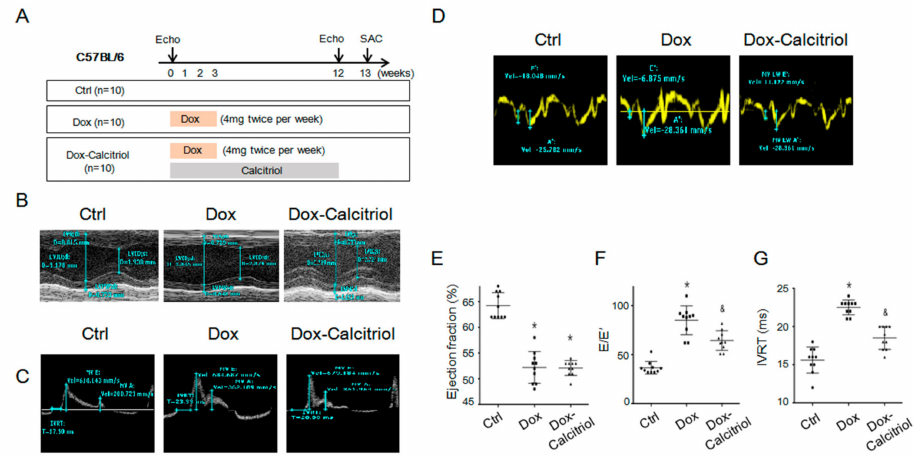
Figure 1. Calcitriol attenuated the doxorubicin-induced impairment of cardiac diastolic function. ( A ) The C57BL / 6 mice were divided into 3 groups (n = 10, in each group). Group 1 (control group) received the same volume of saline injection, group 2 received doxorubicin (4 mg / kg twice weekly for 4 weeks; a cumulative dose of 32 mg / kg) and group 3 received doxorubicin (same dose as group 2) with calcitriol (150 ng / kg / day for 12 weeks). Echocardiography was performed on all the mice before the first dose of doxorubicin injection and 12 weeks after the first dose of doxorubicin injection. All the mice were sacrificed 13 weeks after the first dose of doxorubicin injection. ( B ) Representative M-mode of long-axis echocardiographic images for measurements of the IVSd, LVPWd, LVIDd, and LVIDs. ( C ) Representative sample of pulsed-wave Doppler revealing diastolic function: IVRT, peak velocity of the E wave and A wave. ( D ) Tissue Doppler measurements of septal mitral E’and A’. ( E ) Calculated ejection fraction of M-mode. ( F ) E / E’ ratio by pulse-wave Doppler and tissue Doppler. ( G ) Calculated IVRT by pulsed-wave Doppler. * p < 0.05, vs. Ctrl group. (n = 10 in each group), & p < 0.05, vs. Dox group. (n = 10 in each group). IVSd: interventricular septum thickness at mm end-diastole; LVPWd: left ventricular posterior wall thickness at end-diastole; LVIDd: left ventricular internal dimension at end-diastole; LVIDs: left ventricular internal dimension mm at end-systole, IVRT: iso-volemic relaxation